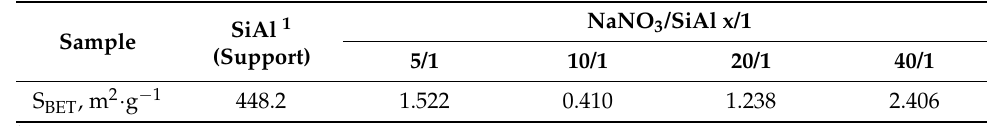
Table 3. Specific surface of support and catalysts (depending on impregnation).